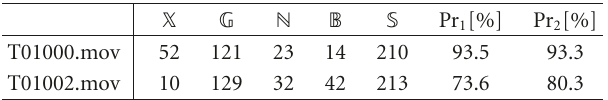
Table 2: Key-frame extraction evaluation results compared to hand labelling ground